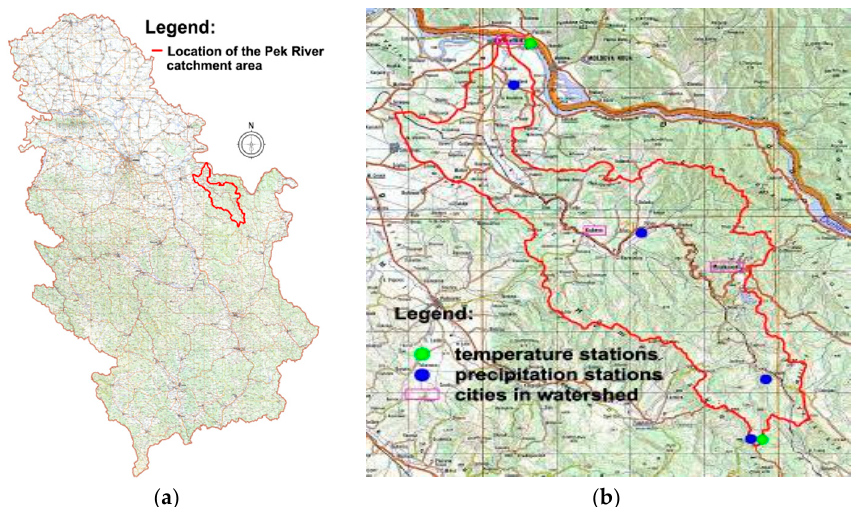
Figure 1. Location of the Pek River C.A. ( a ), positions of the cities, T and P stations in the C.A. ( b ).